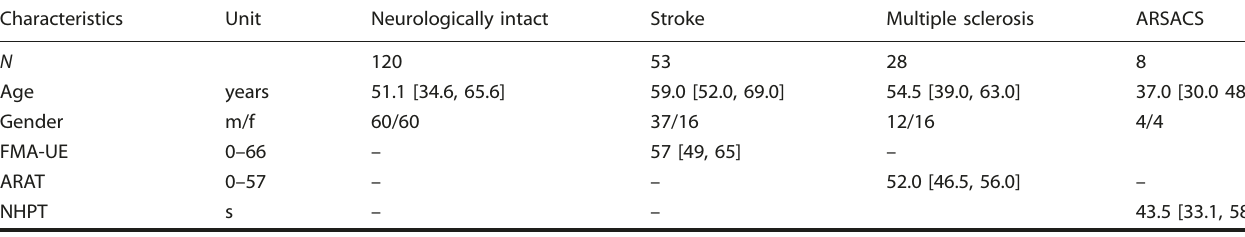
Table 1. Demographics and clinical characteristics of the study population.